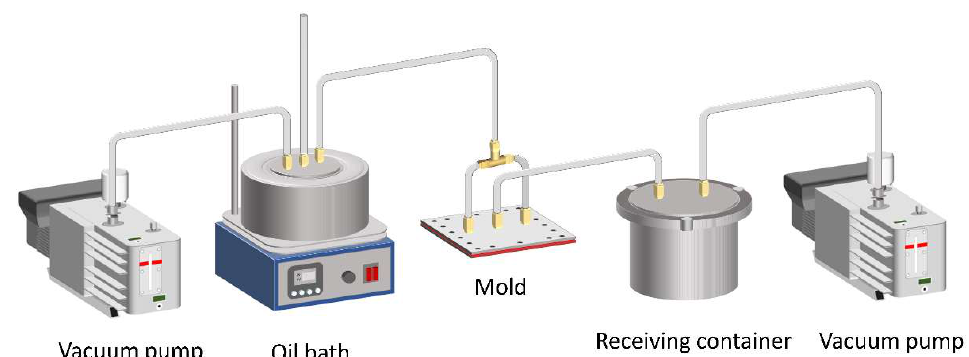
Figure 2. Vacuum-assisted resin transfer molding (VARTM) process.